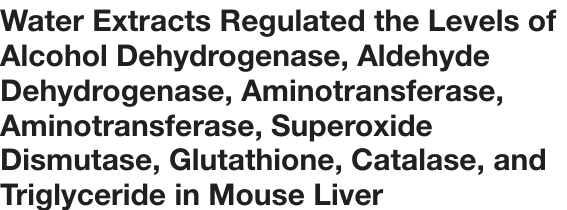
Frontiers in Nutrition |